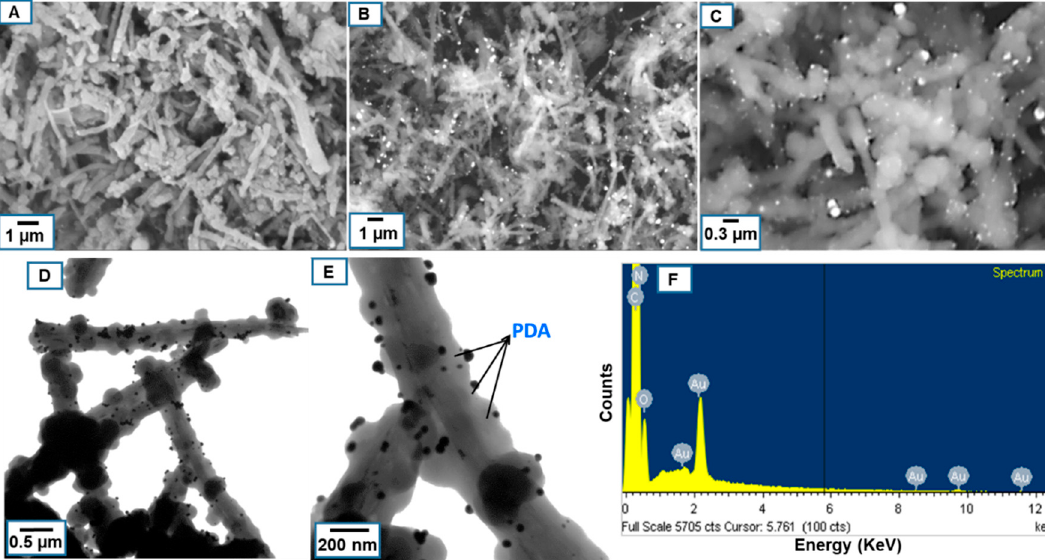
Figure 1. ( A ) SEM images of CNTs/PDA and CNTs/PDA/AuNPs at ( B ) lower and ( C ) higher magnifications. ( D , E ) TEM image of CNTs/PDA/AuNPs at different magnifications. ( F ) EDX spectrum of CNTs/PDA/AuNPs.